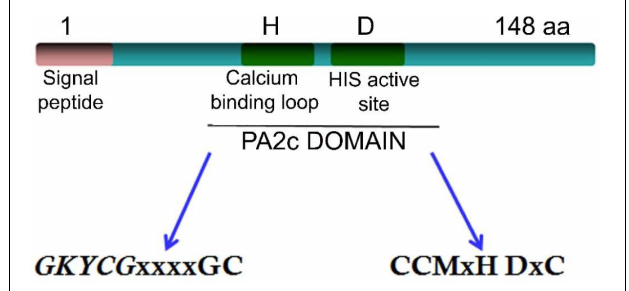
FIGURE 2 | Schematic representation of the Gm sPLA 2